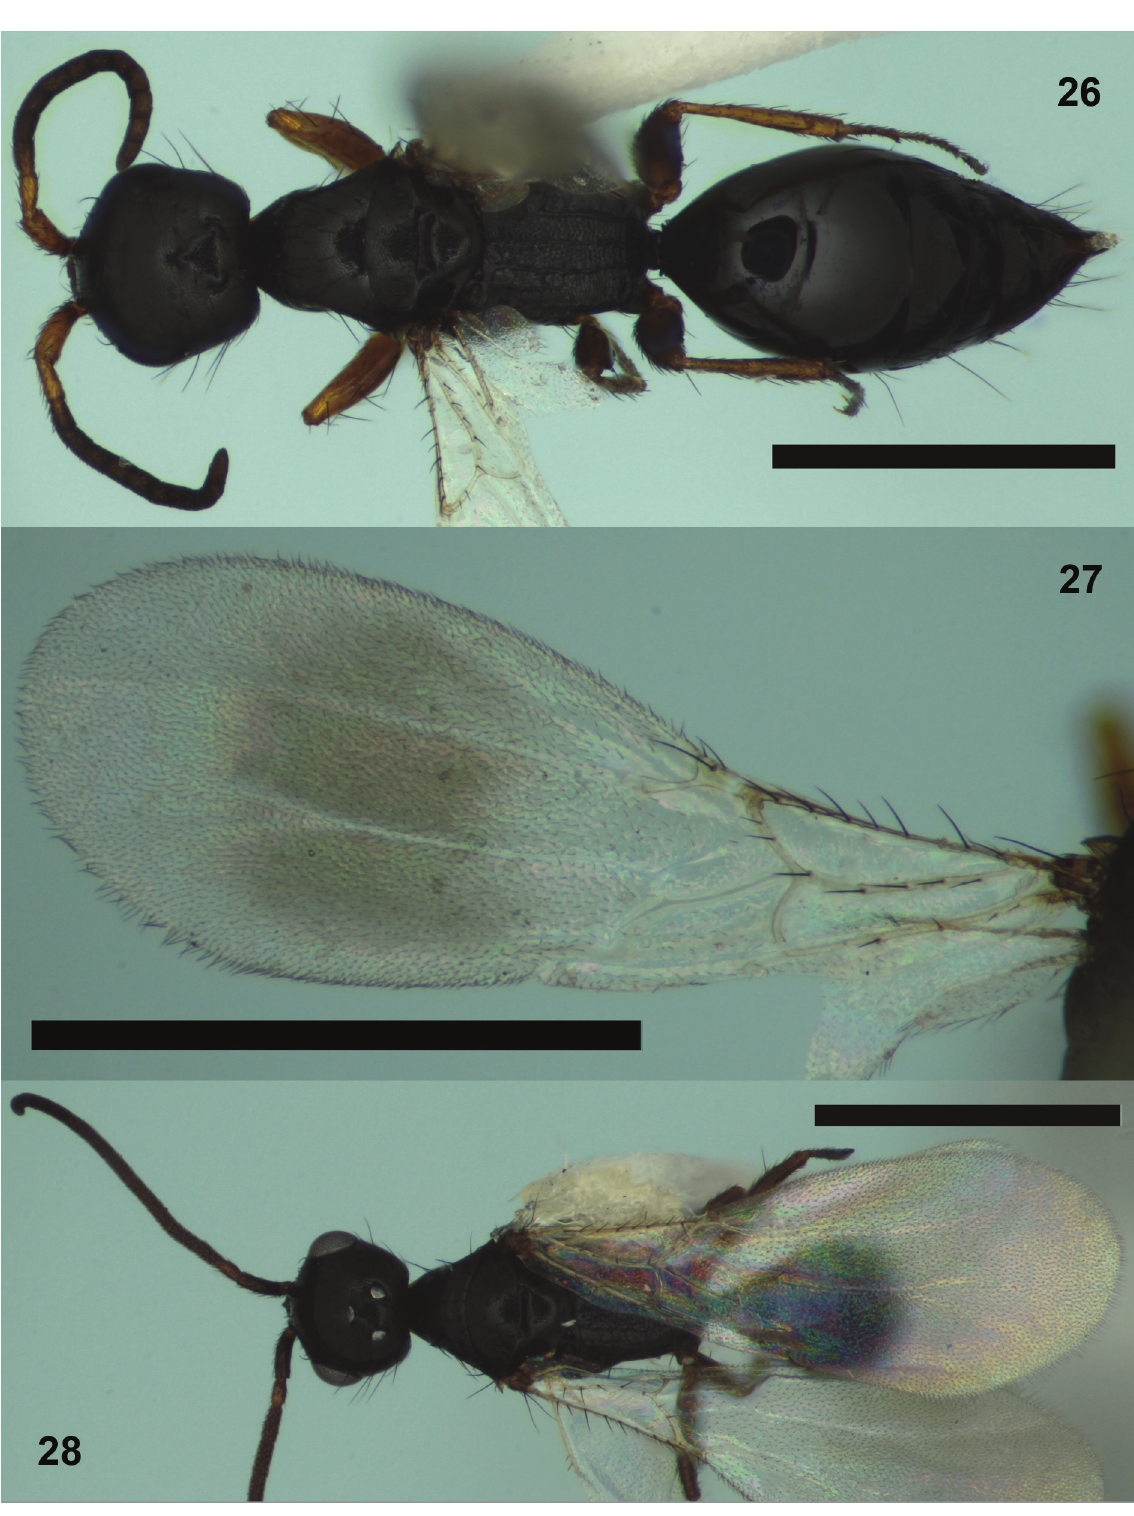
Figs 26–28. Laelius pedatus (Say, 1836), 26–27. ♀, specimen number BMNH(E)968242. 26. Dorsal habitus. 27. Fore wing. 28 . ♂, specimen number BMNH(E)968243, dorsal habitus. Scale bars all 1 mm. © Natural history Museum,